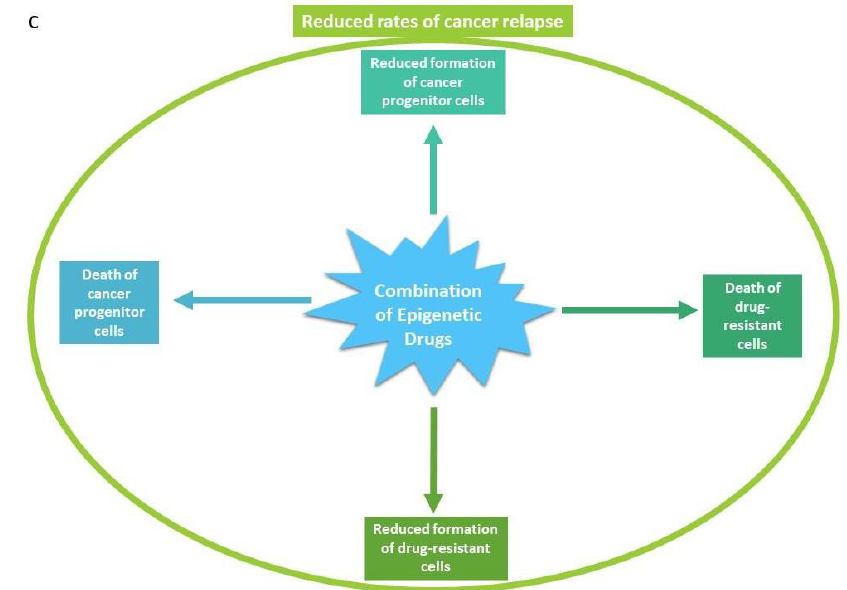
Figure 2. ( A ) Figure 2A depicts a model of antagonistic combination therapy. Drug A, a metabolic product of Drug A, or one of the downstream effectors blocks the effect of Drug B, or the downstream pathway of Drug B, inhibits the effect of combination therapy. ( B ) Figure 2B depicts a model of synergistic combination therapy. Drug A, a metabolic product of Drug A, or one of the downstream effectors, enhances the effect of Drug B or the downstream pathway of Drug B, and vice versa, enhancing the effect of combination therapy. ( C ) Figure 2C depicts a model of the positive effects of a combination therapy including epigenetic drugs. This combination kills the cancer progenitor cell, sensitizes cancer drug-resistant cells, inhibits the production of drug-resistant cancer cells, and inhibits the production of cancer progenitor cells.